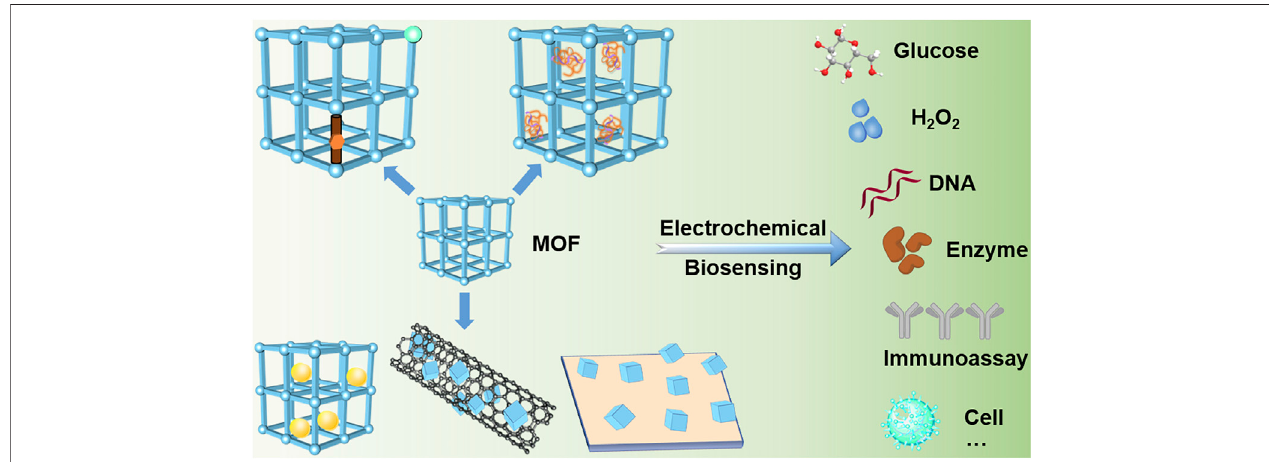
FIGURE1| Illustrationofthe electroactive MOF designing strategies, includingselectredox ligandsor metal centers,combine with biomolecules, and assemblyof composites. The synthesized functional materials are used to detect small biomolecules, biomacromolecules, pathogenic bacteria/cells through electrochemical